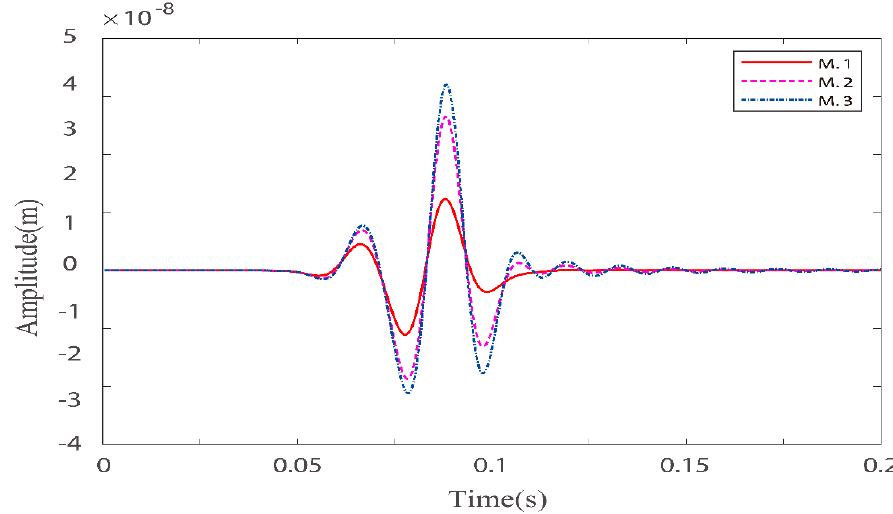
Figure 8. Comparison of liquid–phase x–direction velocity components with three different quality